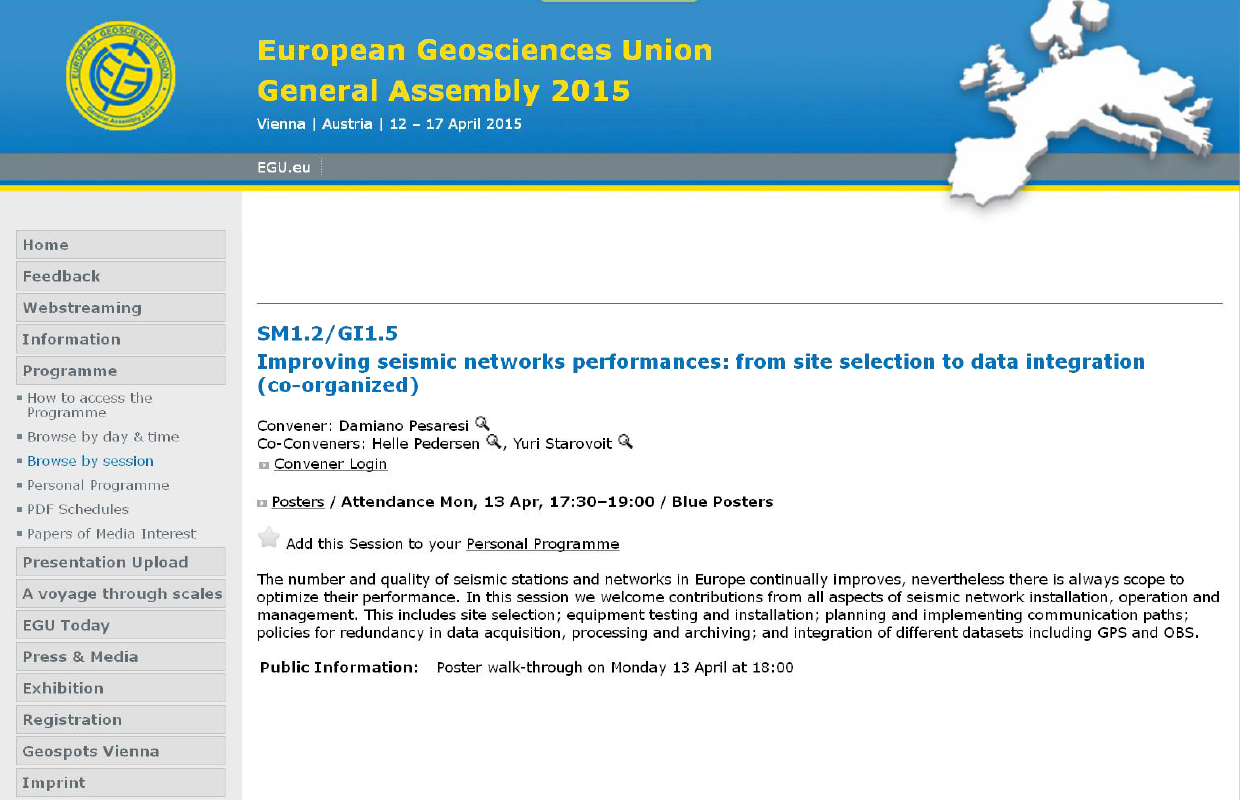
Figure 1. EGU2015 SM1.2/GI1.5 session (from the EGU2015 home